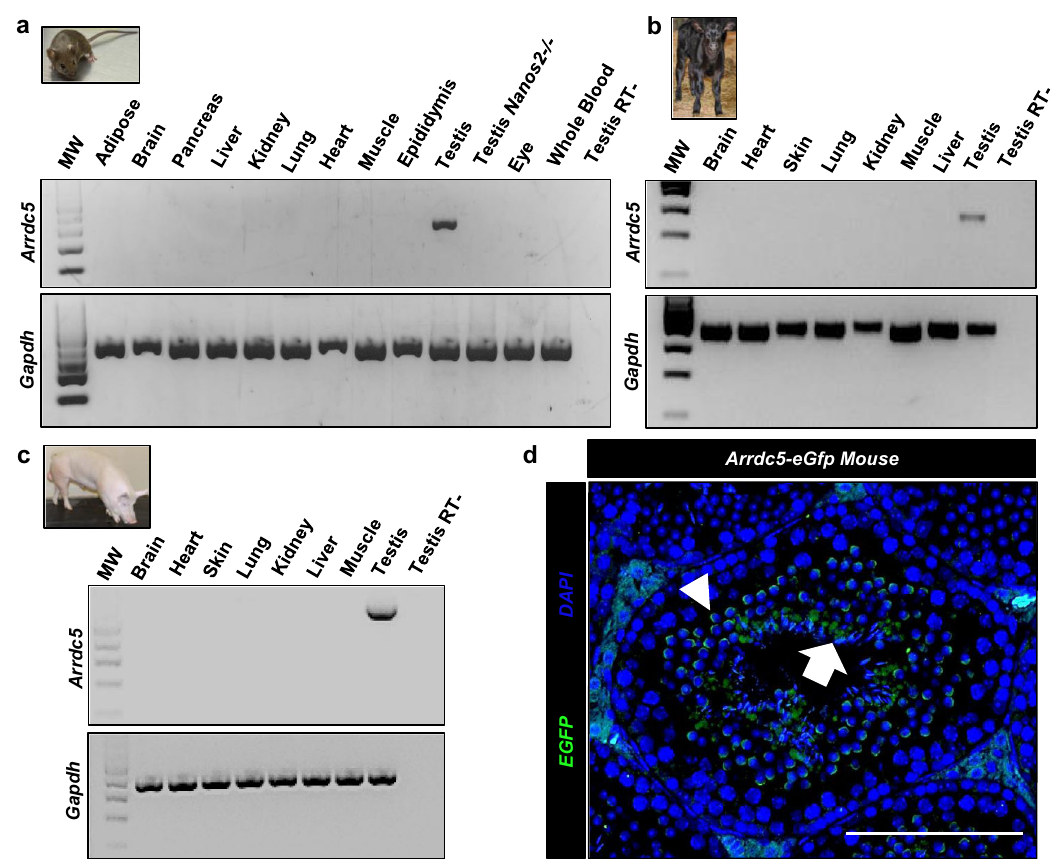
Fig. 2 | Arrdc5 expression pro fi le in mammalian species. a RT-PCR analysis of Arrdc5 mRNA in mouse tissues. MW is 100bp DNAladderand Gapdh wasused as a loading control. Nanos2 − / − testes are ablated of germ cells. b RT-PCR analysis of Arrdc5 mRNAincattletissues.MWisa100bpDNAladderand Gapdh wasusedasa loading control. c RT-PCR analysis of Arrdc5 mRNA in pig tissues. MW is a 100bp DNAladderand Gapdh wasused asaloading control. d Seminiferous tubulecross-